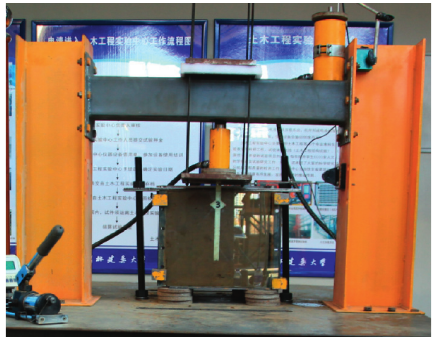
Figure 5: Multifunction test rig.